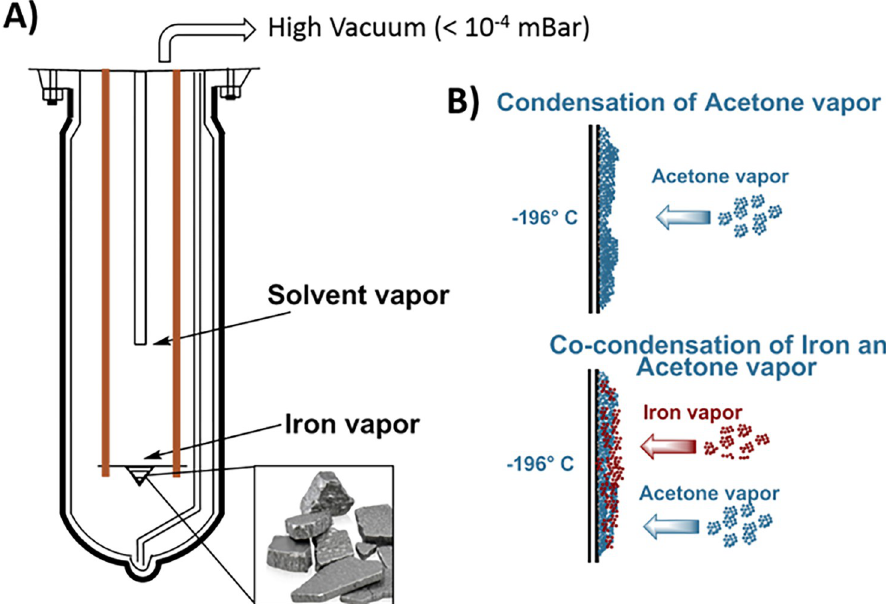
Fig 1. Graphical representation of a metal vapor synthesis reactor (A); Main reactions occurring onto the cold (-196˚C) reactor walls during the MVS process (B). Once the evaporation is stopped, the liquid nitrogen bath is removed, the matrix melts and the acetone solution of Fe NPs is collected by siphoning. This solution is thereafter treated with oxygen and glucose, as described in the text.